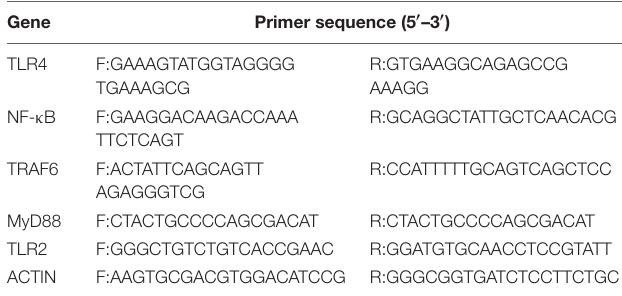
TABLE 2 | Primer sequence design of TLR4, NF- κ B, MyD88, TLR2, and TRAF6.